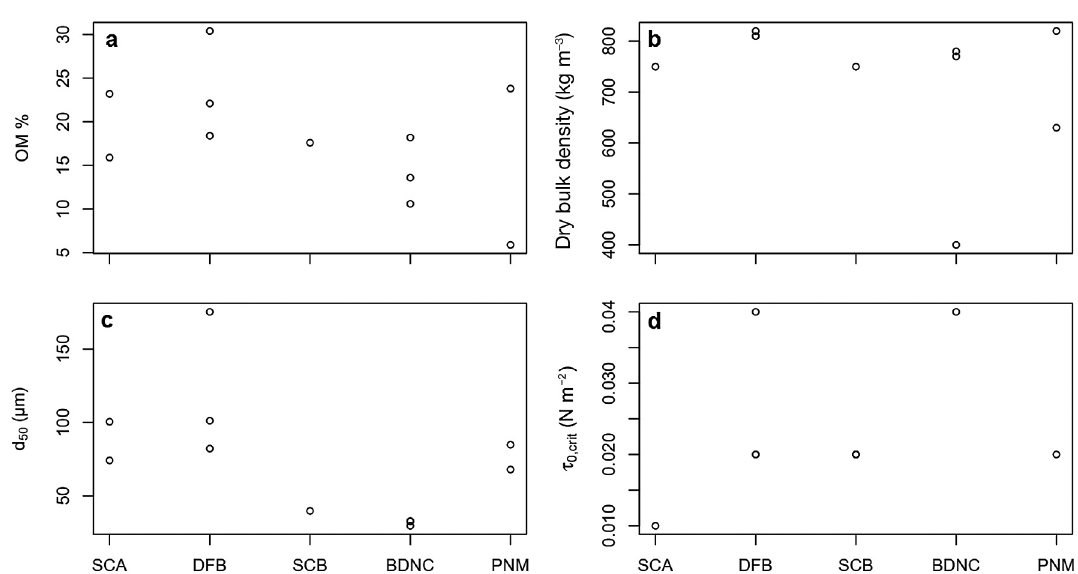
Fig. 4. Same as Fig. 3 but for near-field survey data